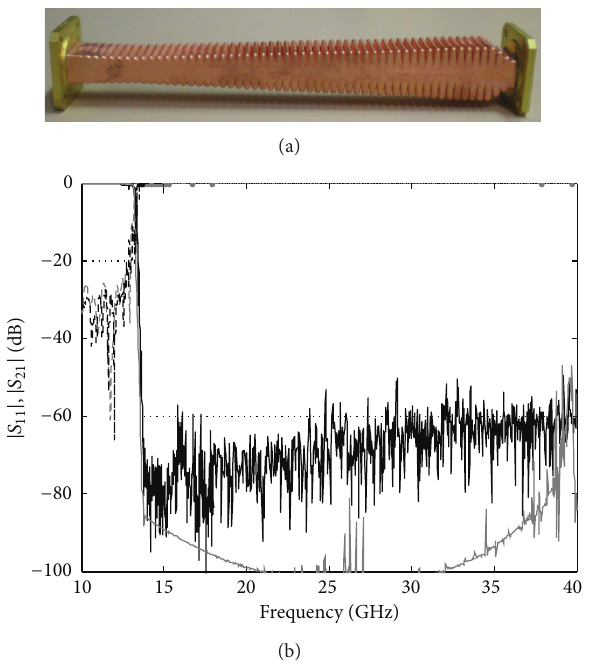
Figure 10: (a) Photograph of the fabricated prototype and (b) simulations (grey line) and measurements (black line) of the novel compact highpower spurious-free low-pass waveguide filter: |𝑆 11 | in dashed line and |𝑆 21 | in solid line. Frequency specifications for |𝑆 11 | and |𝑆 21 | are also given in dotted line.